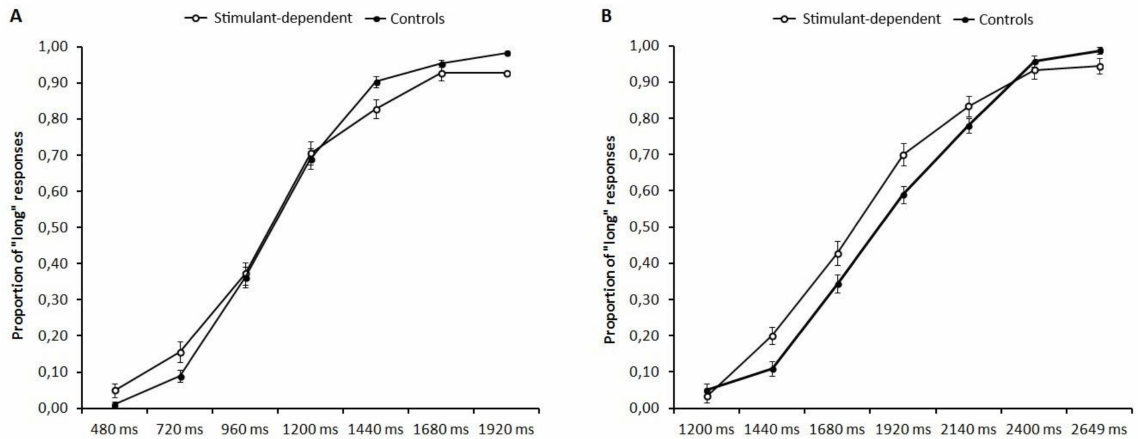
Figure 1. Proportion of “long” responses as a function of temporal intervals for ( A ) Short (480/1920 ms) and ( B ) Long (1200/2640 ms) anchors. Error bars indicate 95% confidence interval.